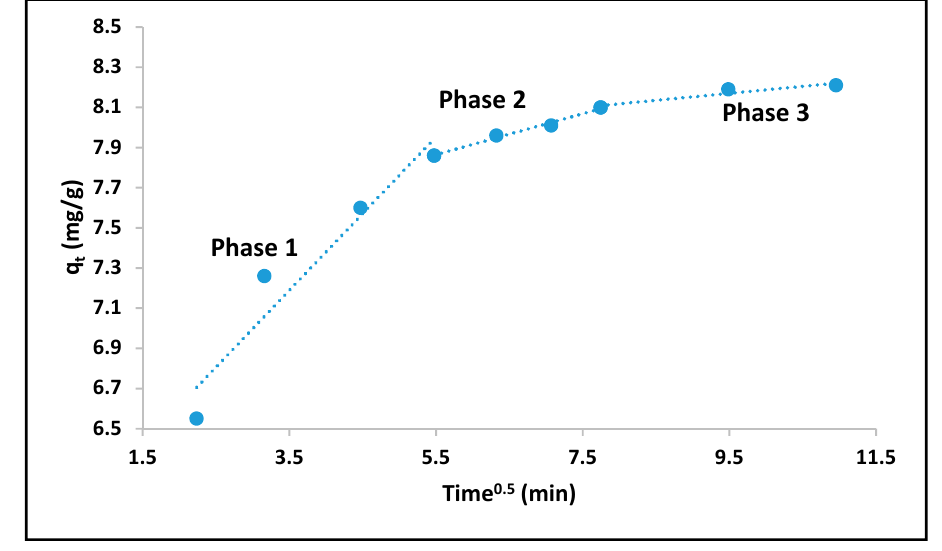
Figure 3. Intra-particle di ff usion plot for As(V) adsorption onto FMK. Table 4. Parameters for intra-particle di ff usion Table 3. Parameters for pseudo-first and second-order reaction kinetics model.